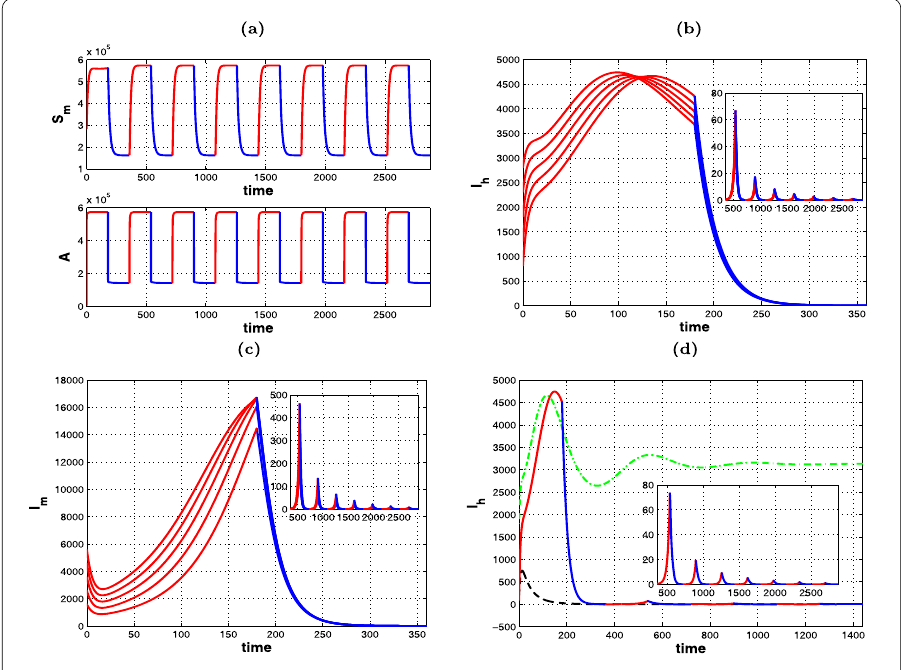
Figure 1 The global dynamics of disease-free solution of model (1) when R 0 < 1